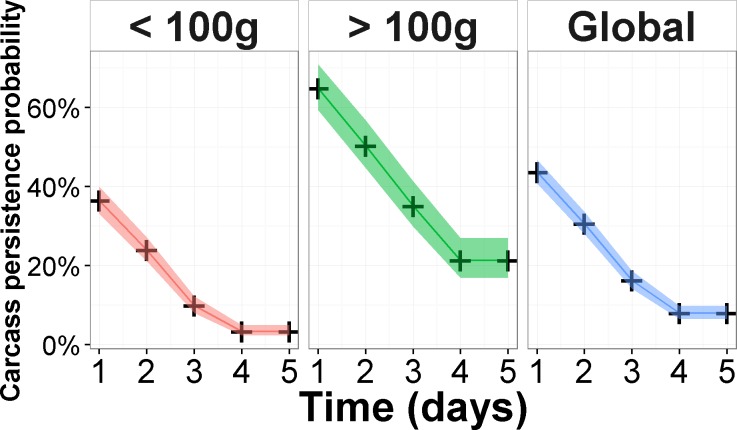
Survival curves from Kaplan-Meier models and corresponding 95% confidence intervals for global data, and body mass classes.